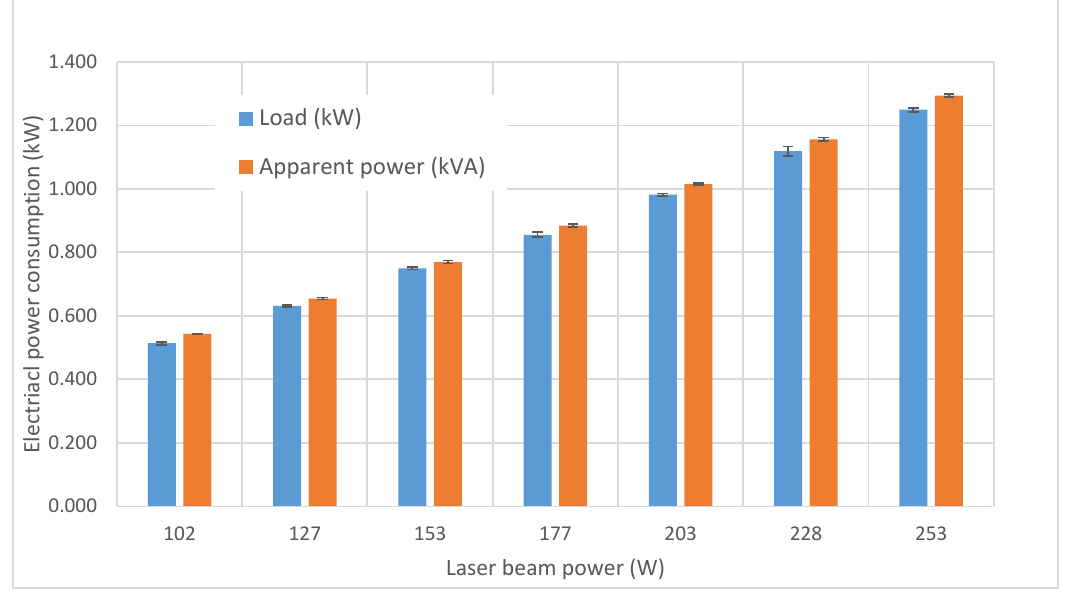
Figure 3. Laser beam power vs. Electrical power consumption.